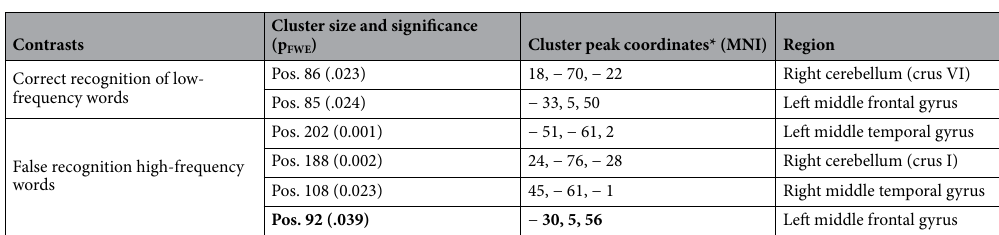
Table 3. Brain activation areas significantly associated with delusion proneness during the correct and false recognition of words, in the 37 participants. The regression analysis model includes delusion proneness, visual imagery, sex, verbal IQ, and Pr-global as predictors. MNI MNI stereotactic coordinates, p FWE family-wise error corrected p -value, * Peak-level corrected significance p FWE < .05 marked in bold coordinates.